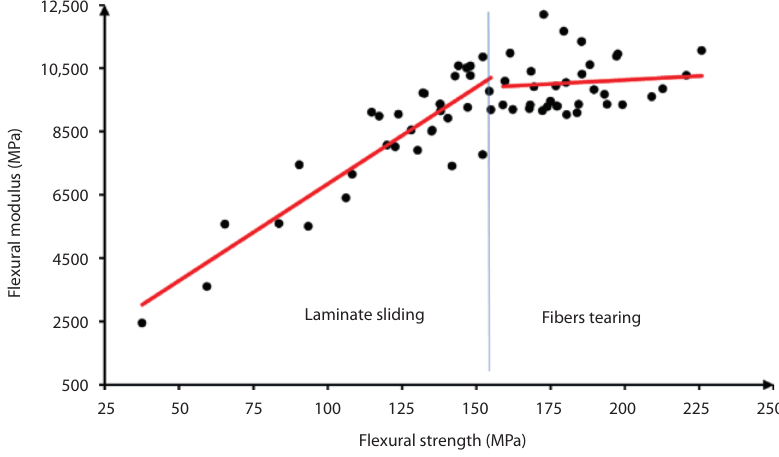
Figure 13: Flexural strength versus flexural modulus plot of PVC/fiberglass composite